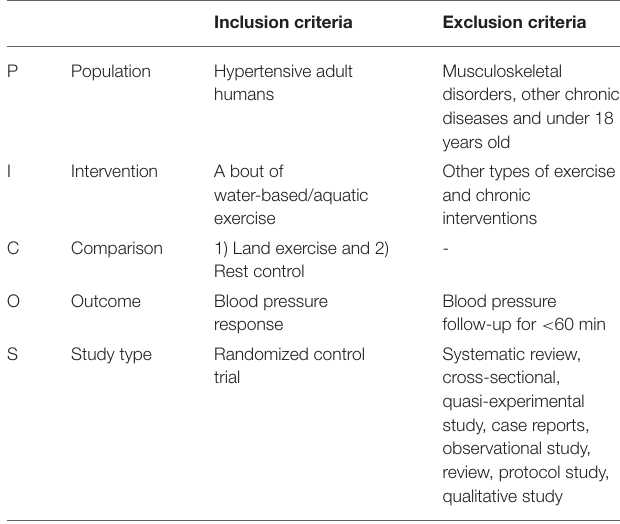
TABLE 2 | Criteria for inclusion and exclusion of studies selected for